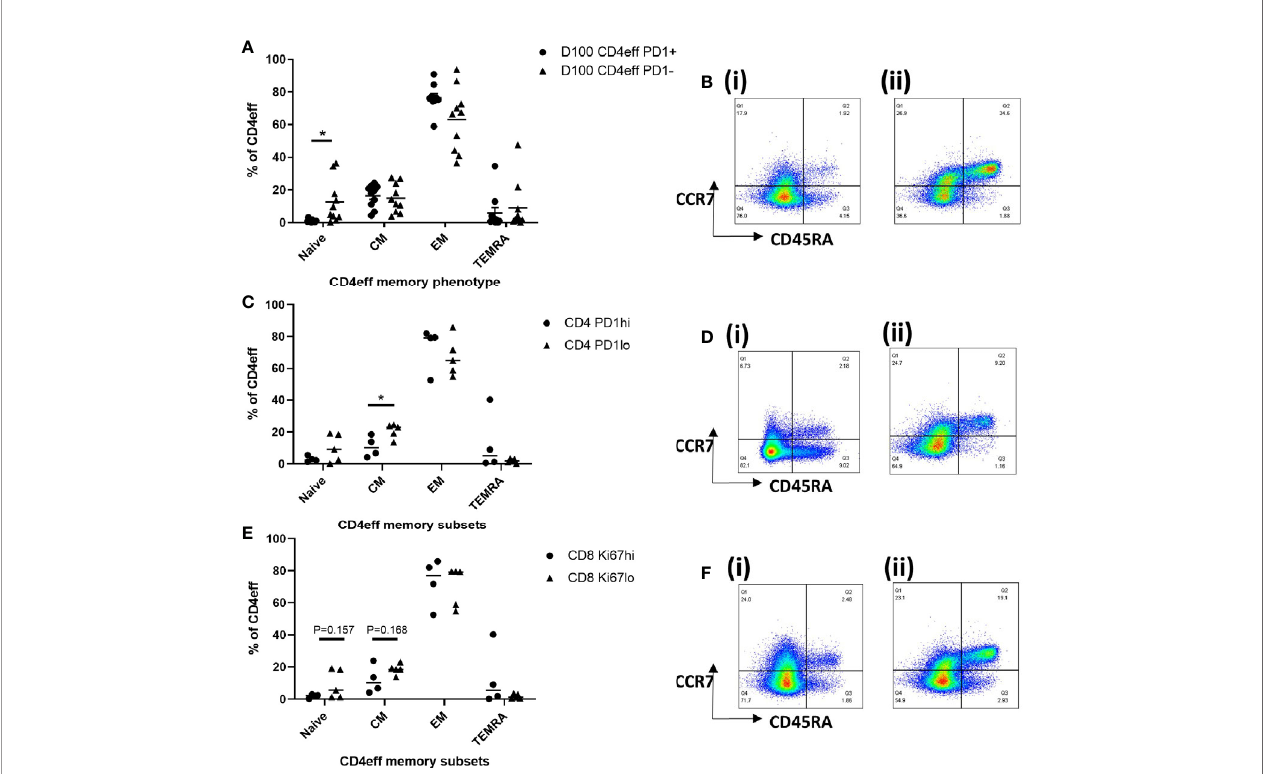
FIGURE 5 | Characterization of T cell memory subsets by fl ow cytometry at D100. (A) Graph of memory phenotypes of CD4eff PD-1+ vs CD4eff PD-1- populations. (B) Flow plots of a single sample showing memory phenotype of (i) CD4eff PD-1+ and (ii) CD4eff PD-1-. (C) CD4 memory phenotype of patients with high (frequency that is above median, n=4) or low (frequency that is equal to and below median, n=5) frequency of CD4eff PD-1+. (D) Flow plots showing memory phenotype of CD4eff from representative patients with (i) high and (ii) low frequency of CD4eff PD-1+ cells. (E) CD4 memory phenotype of patients with high or low frequency of CD8 Ki-67+ cells; (F) Flow plots showing CD4eff memory phenotype from representative patients with (i) high and (ii) low frequency of CD8 Ki-67+. Median indicated. Statistical analysis by Student t -test *p < 0.05, paired analysis in (A)